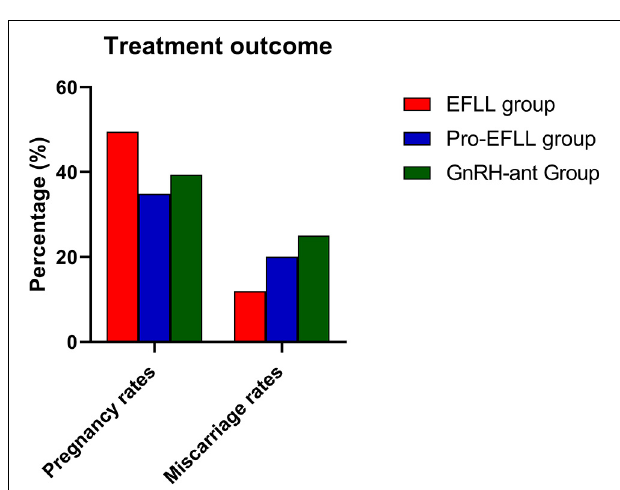
FIGURE 6 | Comparison of pregnancy rates and miscarriage rates among EFLL, Pro-EFLL, and GnRH-ant protocol. Values are presented as